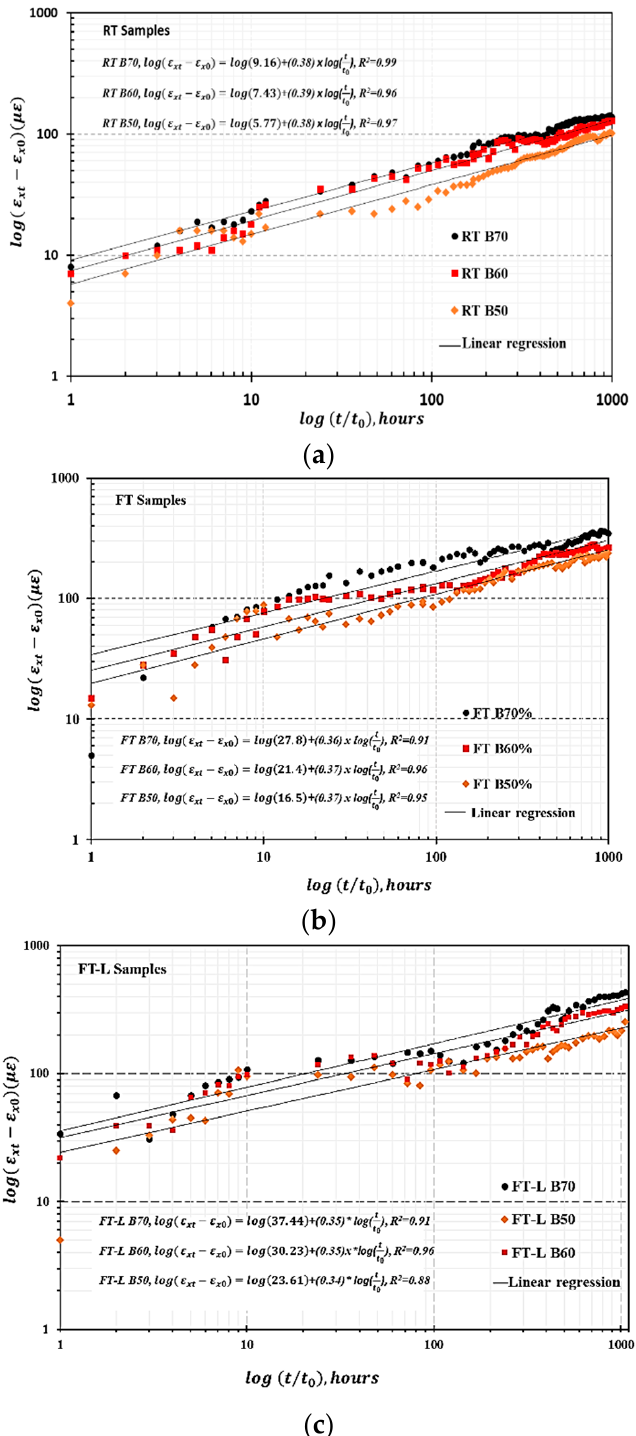
Figure 9. Evaluation of creep parameter n and m ( a ) for RT samples, ( b ) for FT samples, and ( c ) for FT-L samples.